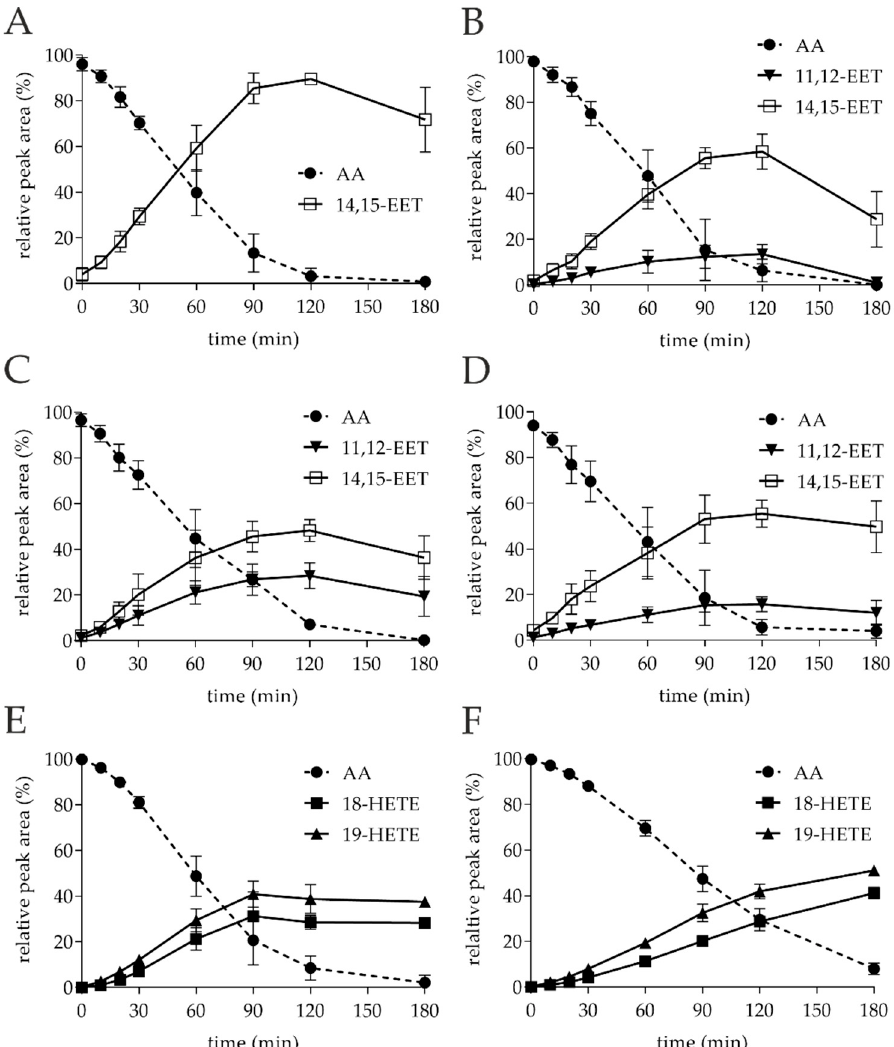
Figure 3. Time courses of AA conversion by different UPOs (0–180 min, n = 6). Reactions were car- ried out with 1 mM AA in 20 mM sodium phosphate buffer (pH 7.0) in the presence of 20% ( v / v ) acetone, 2% ( w / v ) glucose, 2 U mL − 1 UPO and 0.04 U mL − 1 glucose oxidase. The peak areas detected by HPLC-ELSD are given as relative peak areas (%) related to the total areas in the chromatograms. ( A ): Tan UPO; ( B ): Cgl UPO; ( C ): Mro UPO; ( D ): Mwe UPO; ( E ): Aae UPO; ( F ): Cra UPO;